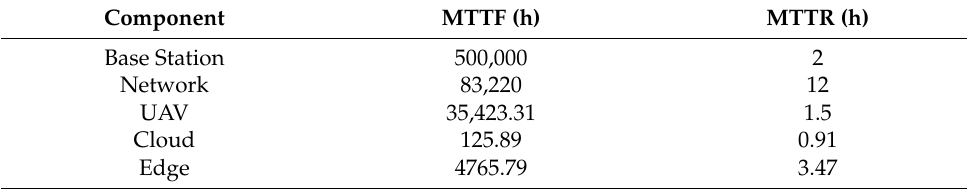
Table 4. Values used in numerical